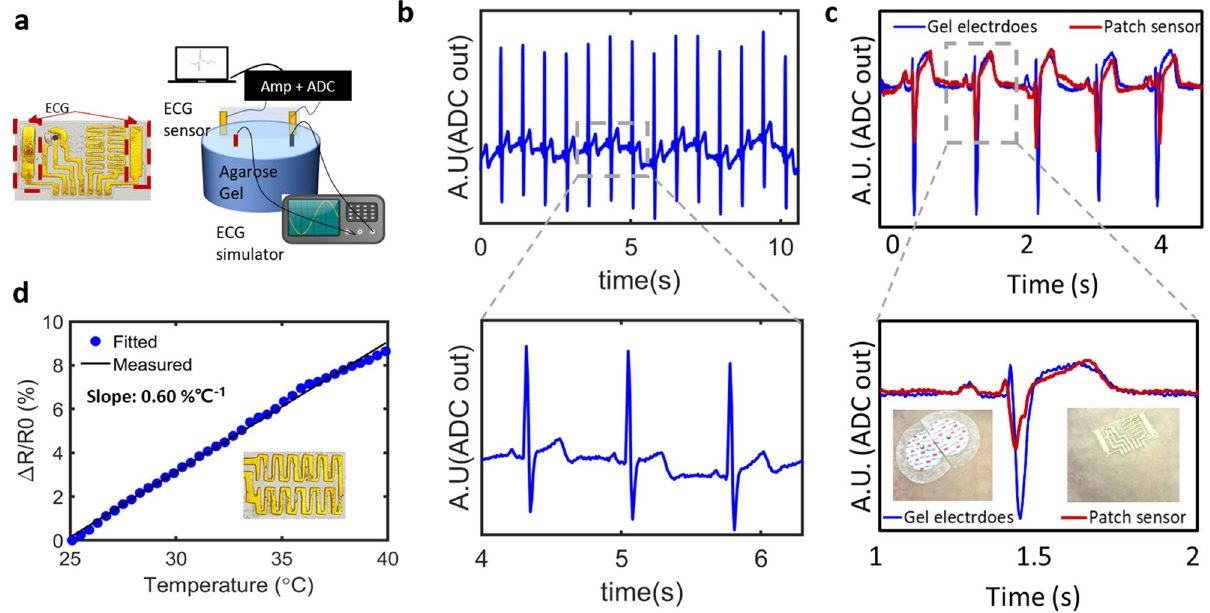
Figure 6. Electrical and thermal characterisations for ECG and temperature monitoring. ( a ) Schematic of the measurement of ECG signals using a chest phantom and ECG simulator. ( b ) Recorded ECG signals using the proposed ECG sensor and magnified view clearly showing PQRST waveforms. ( c ) ECG signal measured from the patch sensor attached on the chest of human subject, compared to the signal from conventional gel-type electrodes. ( d ) Linearly increasing resistance of the temperature